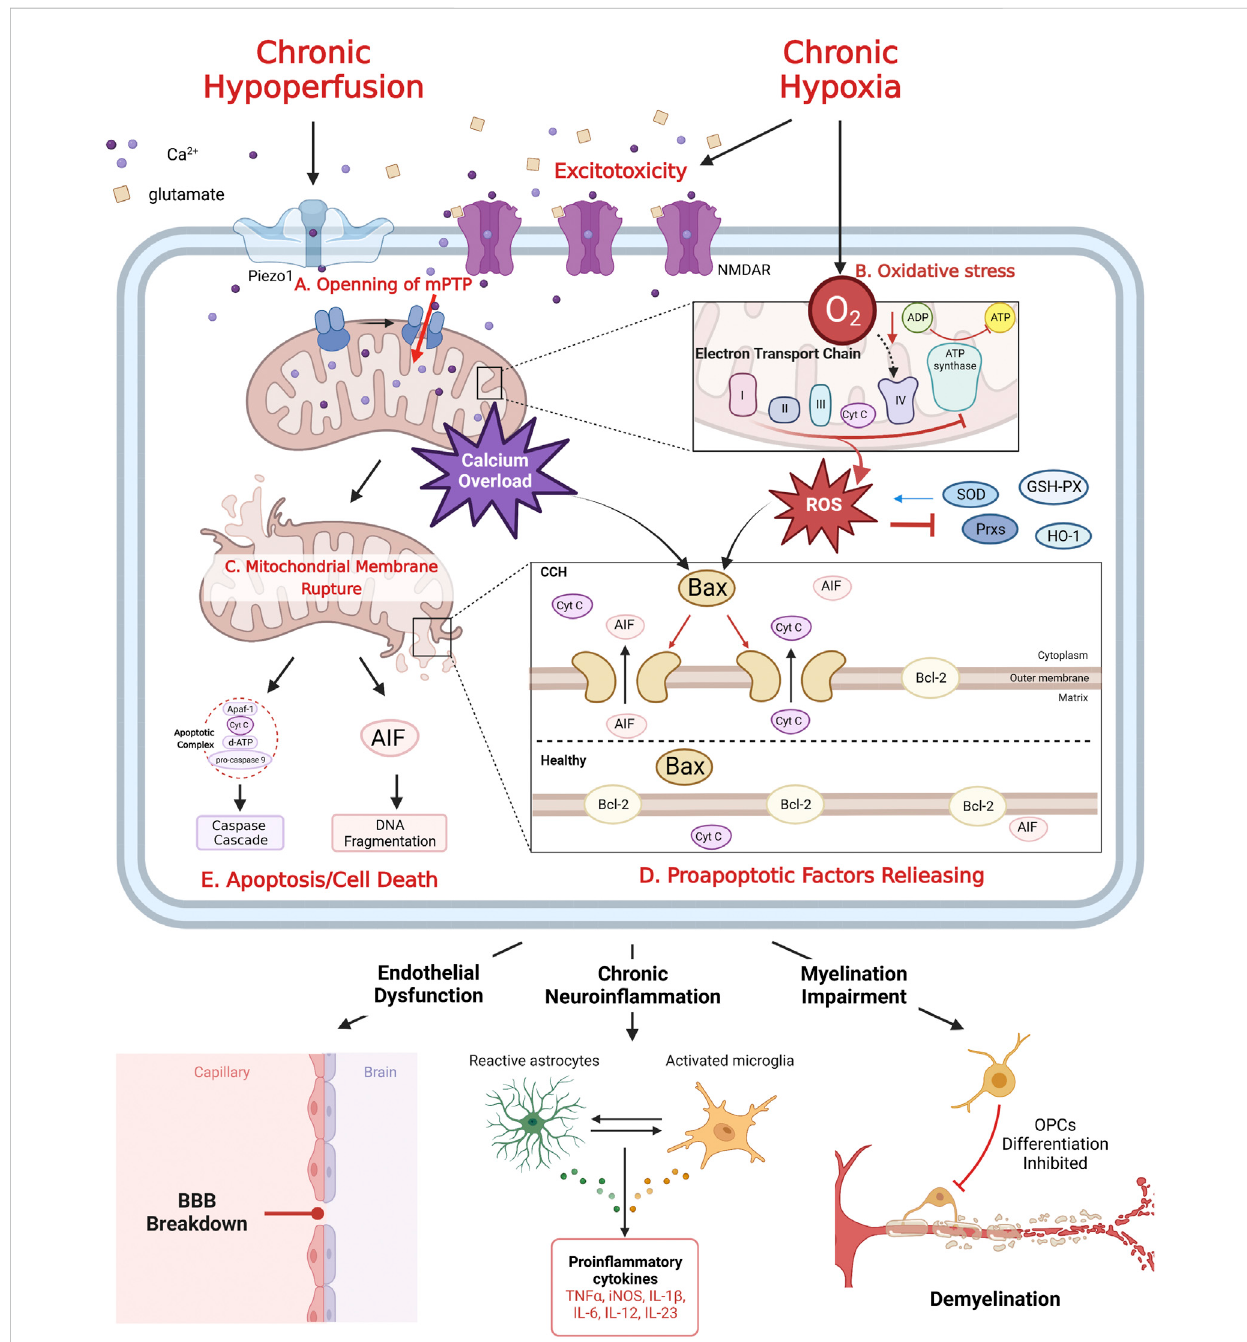
FIGURE 1 The mechanism of mitochondrial dysfunction after CCH. CCH related excitotoxicity induced mPTP formation (A) , which leads to calcium overload. Chronic hypoxia inhibits mitochondrial oxidative phosphorylation, resulting in excessive production of ROS, inhibition of ETC complex and antioxidant enzymeinactivation, eventually oxidativestress (B) . Calcium overloadandoxidativestress rupture mitochondrial outermembrane (C) ,trigger therelease of pro-apoptotic factors (Cyt C and AIF) (D) , which mediate Caspase cascade and DNA fragmentation, respectively, leading to apoptosis/cell death (E) . Meanwhile, Bcl-2 family proteins play a key role in regulating the release of anti-apoptotic factors (D) . Mitochondrial dysfunction is the key to CCH induced neurovascular injury: endothelial dysfunction, chronic neuroin fl ammation and myelination